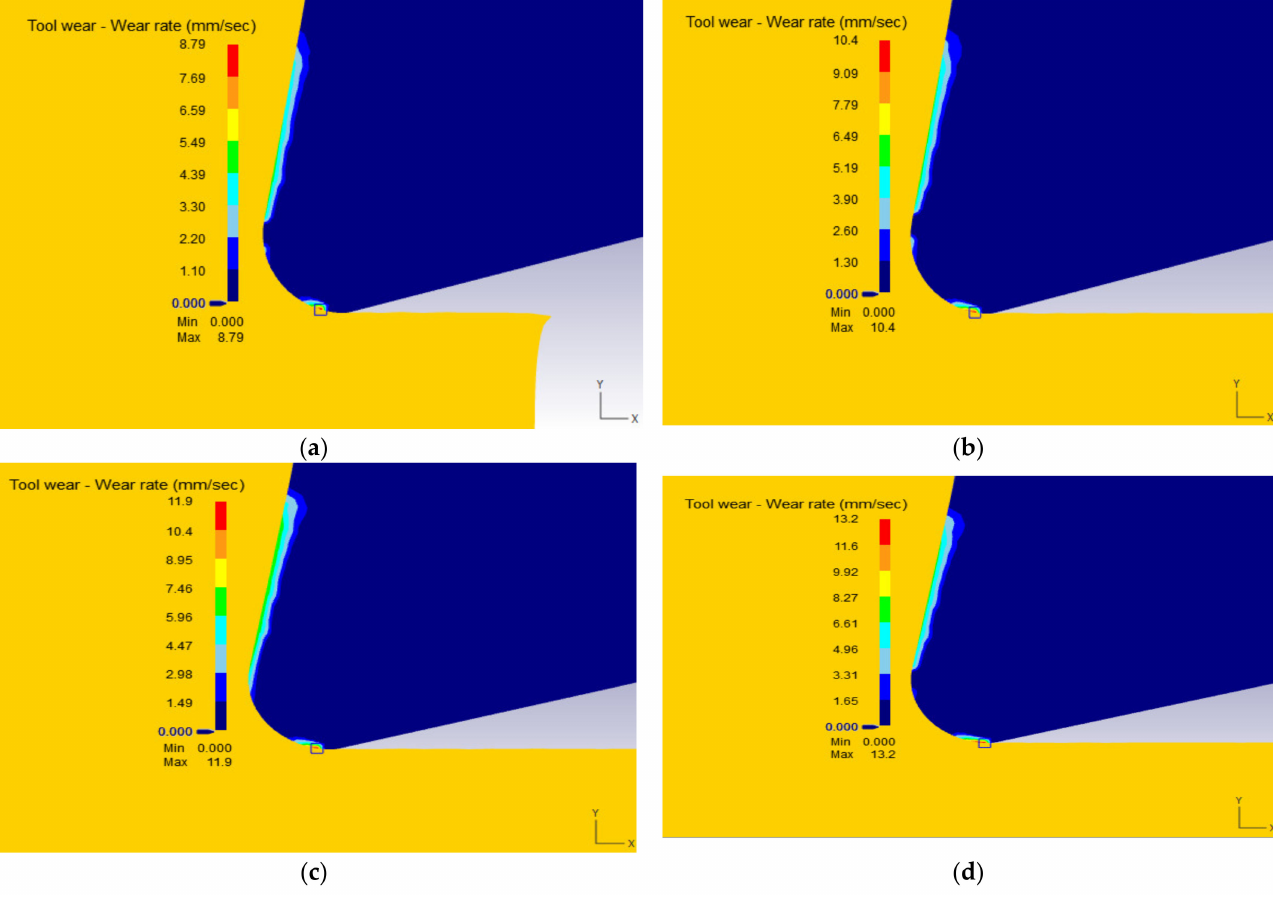
Figure 8. The simulation results for tool wear rate at V = 400 m/min, f = 0.1 mm/rev, γ = 5 ◦ for the nose radii r c : ( a ) 0.3 mm, ( b ) 0.5 mm ( c ) 0.7 mm and ( d ) 0.9